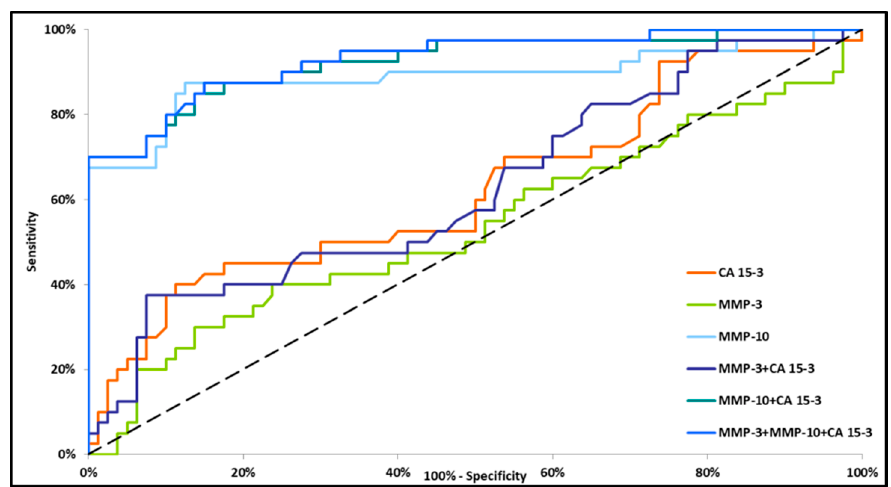
Figure 2. Diagnostic criteria of the ROC curve in stage I of BC. CA 15-3—cancer antigen 15-3; MMP-3—stromelysin-1; MMP-10—stromelysin-2.